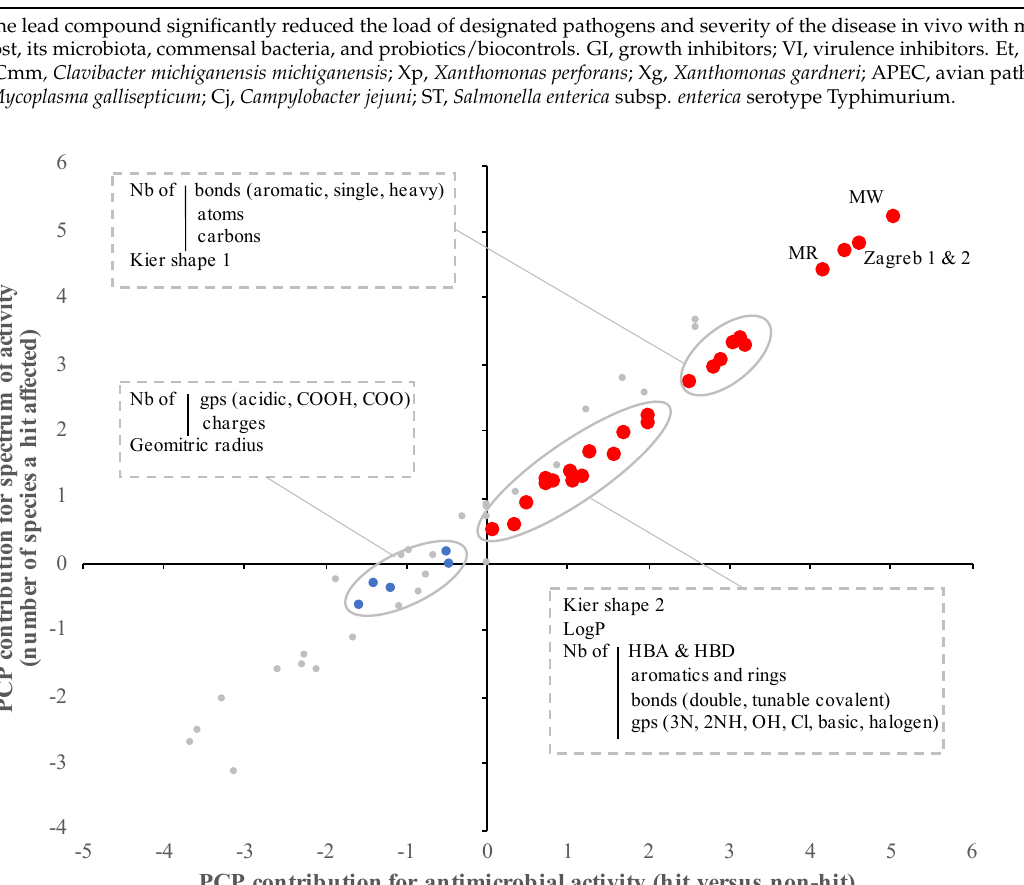
Figure 1. Impact of physico-chemical properties (PCP) on the antimicrobial activity and spectrum of activity of the small molecules (SM). The antimicrobial activity/activity spectrum model was built based on the in vitro data from the primary screenings ( n = 11 screenings) and the PCP of the SM obtained from multiple reference database (ChemBridge, PubChem, Joelib, ChemMine, and OpenBabel). The contribution of each PCP was determined based on the bootstrap forest method. The contribution score was log-transformed. Red dots represent PCP significantly associated with both antimicrobial activity and spectrum of activity of the SM ( p < 0.01). Blue dots represent PCP significantly associated with only the spectrum of activity of the SM ( p < 0.01). Gray dots represent PCP not associated with antimicrobial activity and spectrum of activity of the SM ( p > 0.001). Nb: number; Gp: group; LogP: lipophilicity; HBA: hydrogen bond acceptor; HBD: hydrogen bond donor.